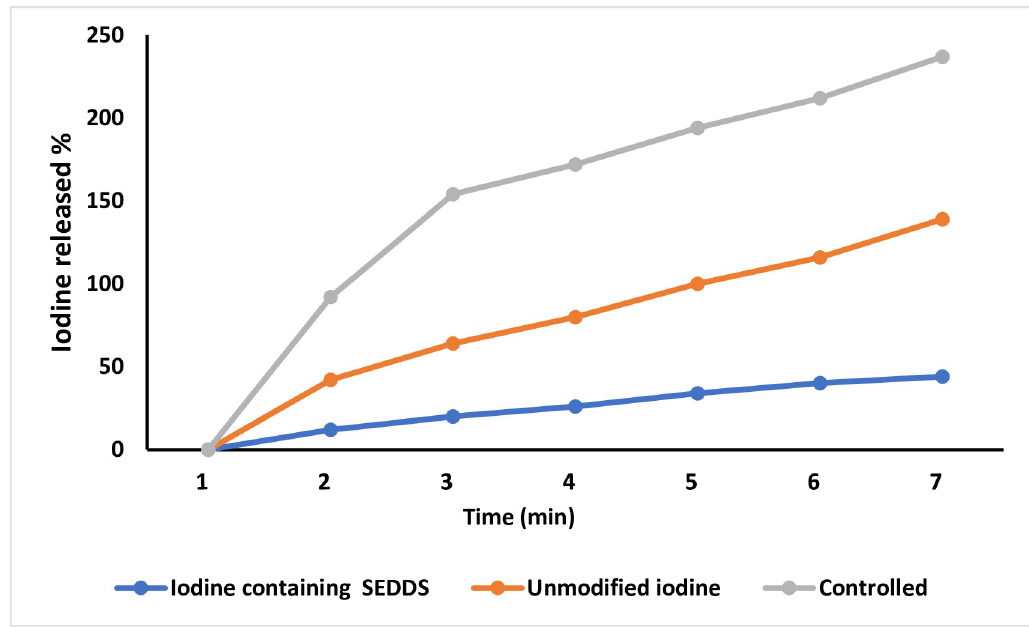
Fig 7. Iodine release from oily droplets of SNEDDS over the time period of 7 hrs.